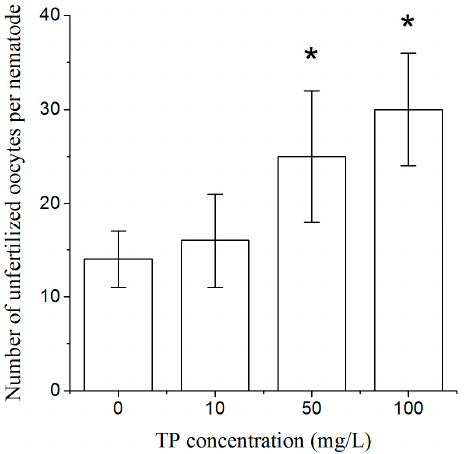
Figure 4. The number of unfertilized oocytes per nematode exposed to TP for 4 h. TP, Triptolide. Bars represent means ± SEM. * p < 0.05 vs. the control group.